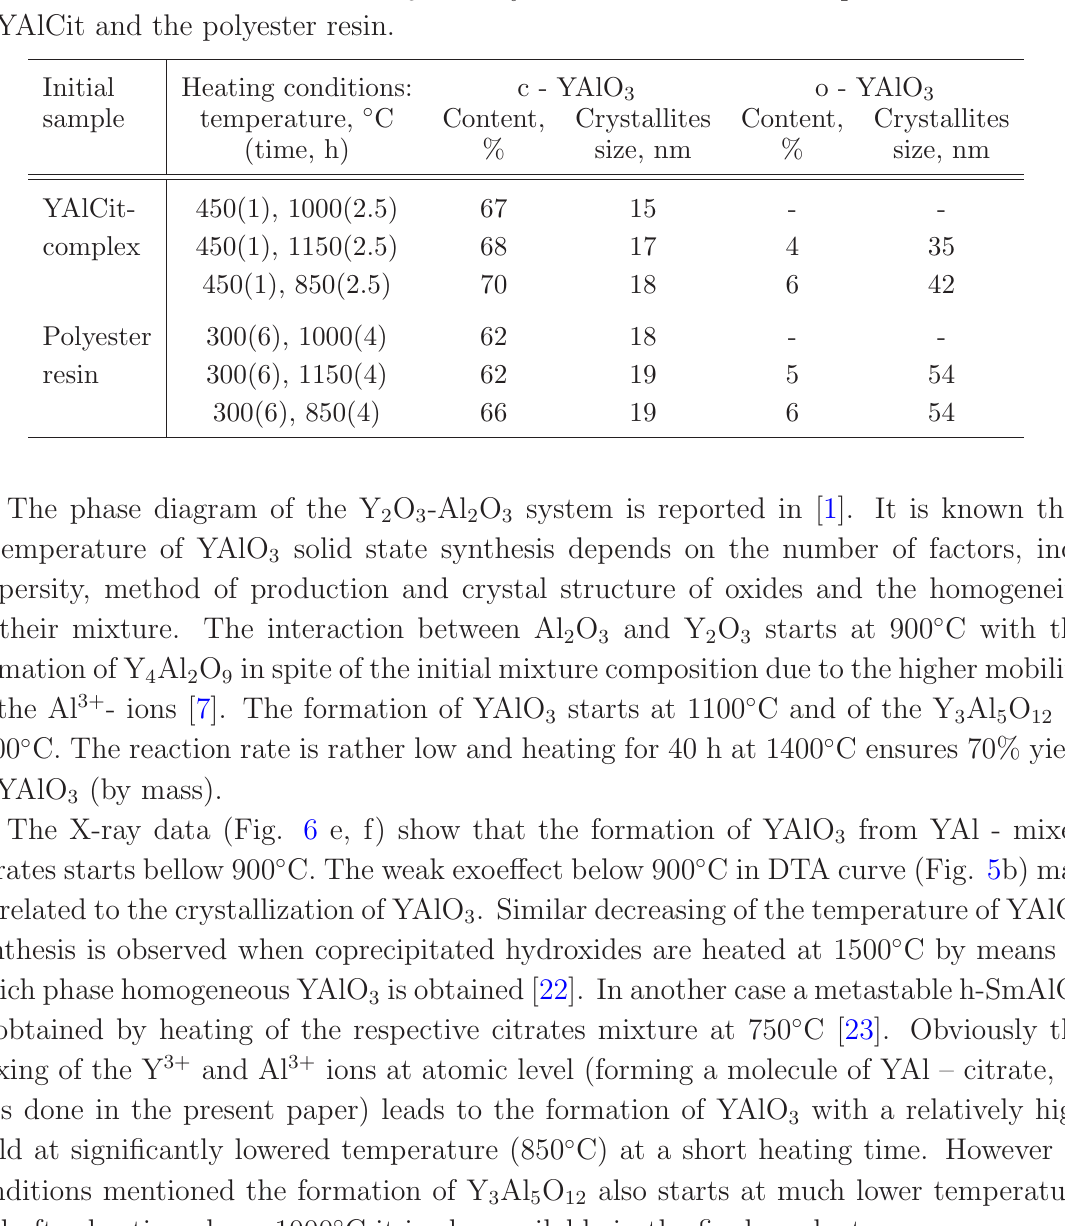
and crystallites size of the final products of heating 3